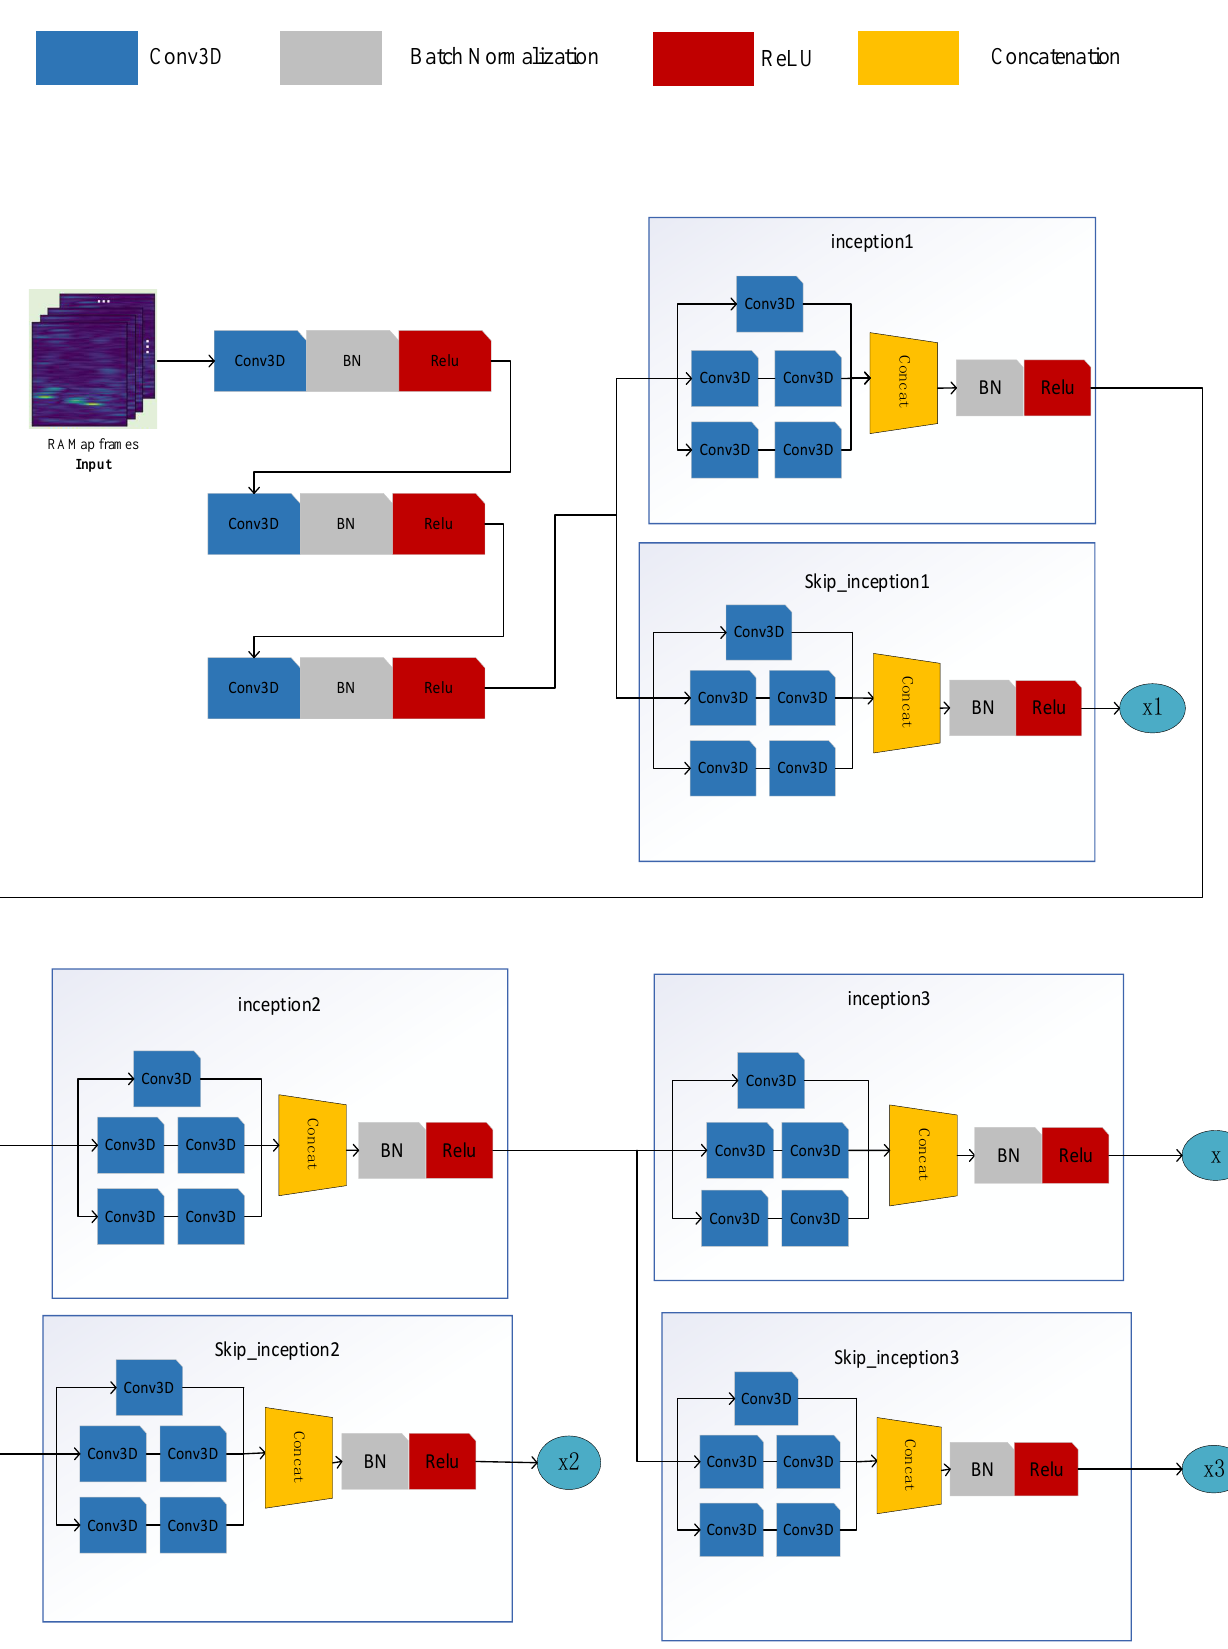
Figure 4. Hourglass three-dimensional convolutional neural network encoder with temporal incep- tion convolution layers.